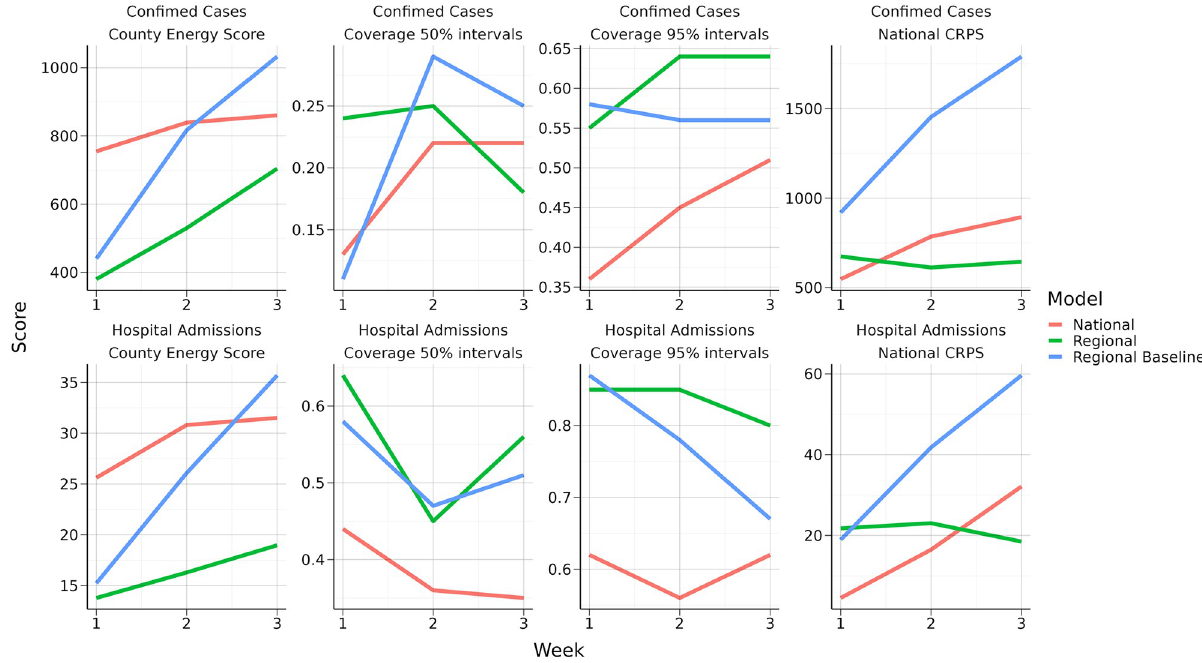
Fig 5. Performance scores. Average county energy score, national CRPS and county level coverage of 50 and 95% PI for the regional and national model.